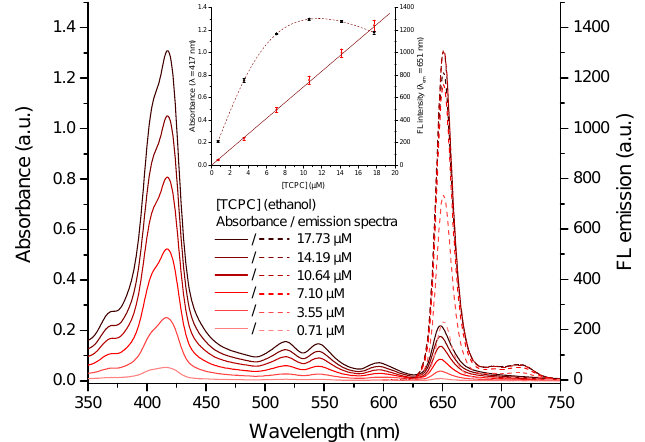
Figure 2. Absorbance (solid lines) and fluorescence ( λ ex = 415 nm, dashed lines) spectra of TCPC solu- tions in ethanol at different concentrations. Inset: Absorbance and FL intensity vs. TCPC concentration. The error bars were calculated from the standard deviation of three independent